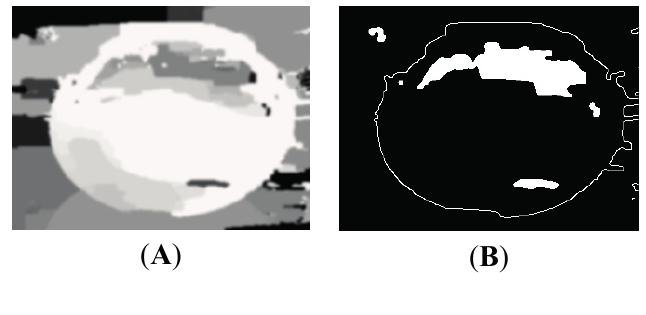
Figure 14. Filters ( A ) Smooth image ( B ) Threshold image.